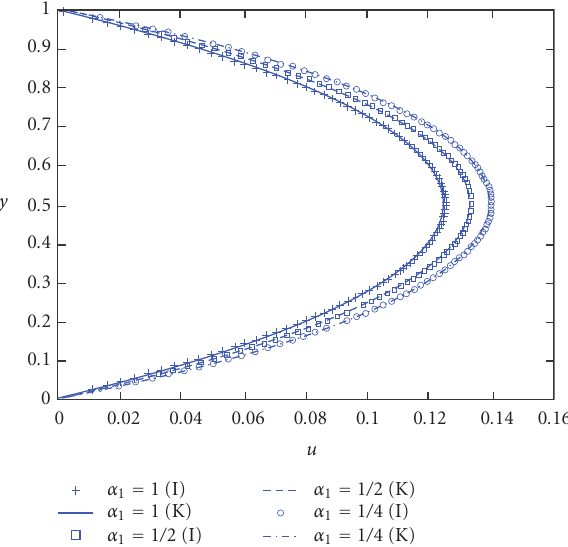
Figure 4.3. Velocity profiles for various values of α 1 and fixed α 2 = 1 (I: Wang et al. solution; K: our solution) for dp/dx = − 1.